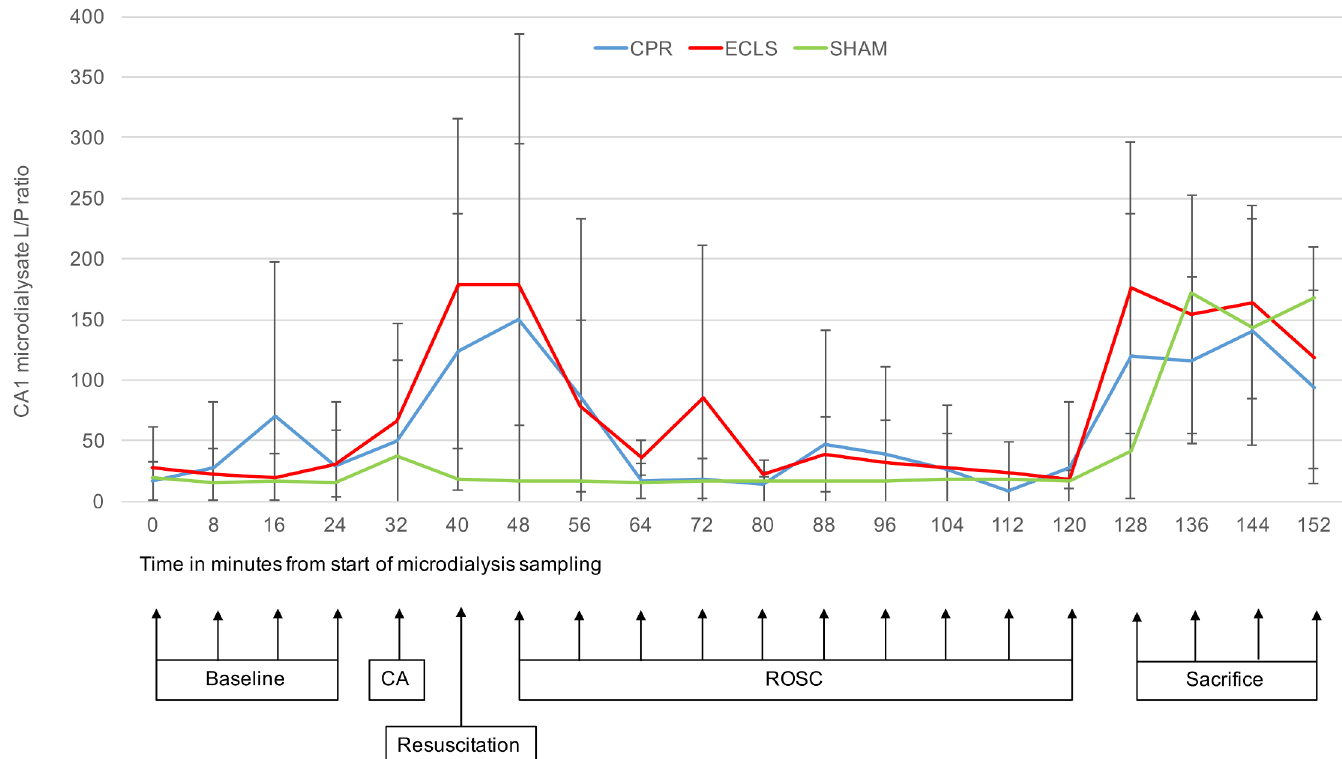
Fig 3. CA1 lactate/pyruvate ratio against time. x-axis: Point of measurement, measurements 8min apart (sampling interval of 8min); y axis: Lactate/ pyruvate ratios (mean values and standard deviation); CA, cardiac arrest; CPR, cardiopulmonary resuscitation; ECLS, extracorporeal cardiopulmonary life support; BL, baseline; ROSC, return of spontaneous